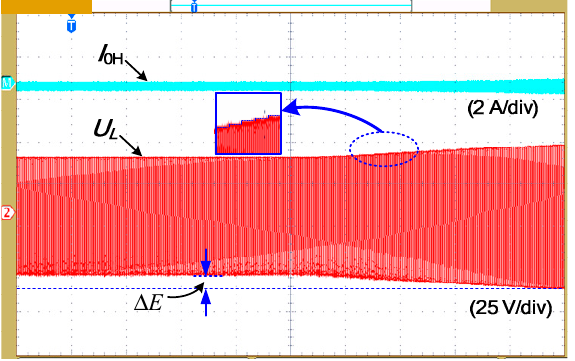
Figure 13. The circulating current and PCC voltage of DGs when only voltage recovery operation is performed.